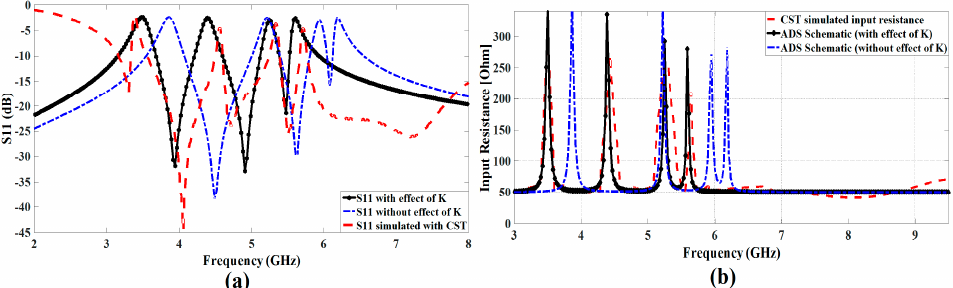
Figure 6. ( a ) Magnitude of the S11 parameter ( a ), and ( b ) of the antenna input resistance versus frequency. Results computed using Computer Simulation Technology (CST) and Advanced Design System (ADS) software tools.